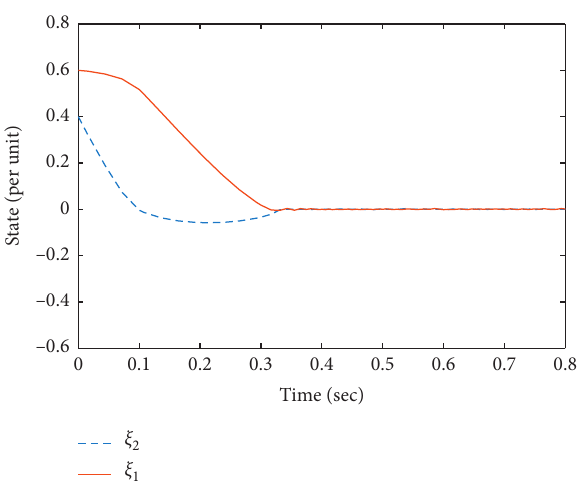
Figure 2: State trajectory of x